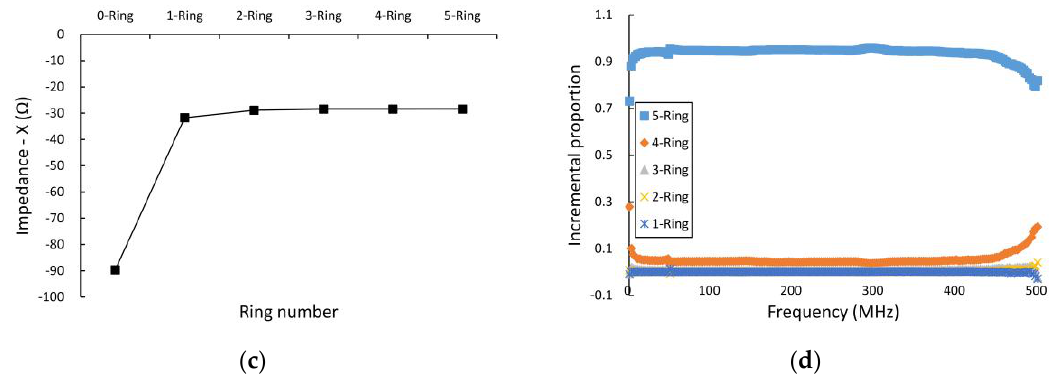
Figure 6. Results of horizontal effective depth measurement of the electrode’s electric field. ( a , b ) show the imaginary part of the electrode’s output impedance versus injected DD water in the PP tubes from the first ring to the fifth ring; ( c , d ) show the imaginary part of the electrode’s output impedance versus DD water injection into the PP tubes from the fifth ring to the first ring.